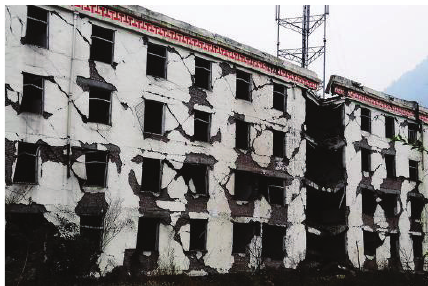
Figure 1: The Xuankou High School Student Dormitory.